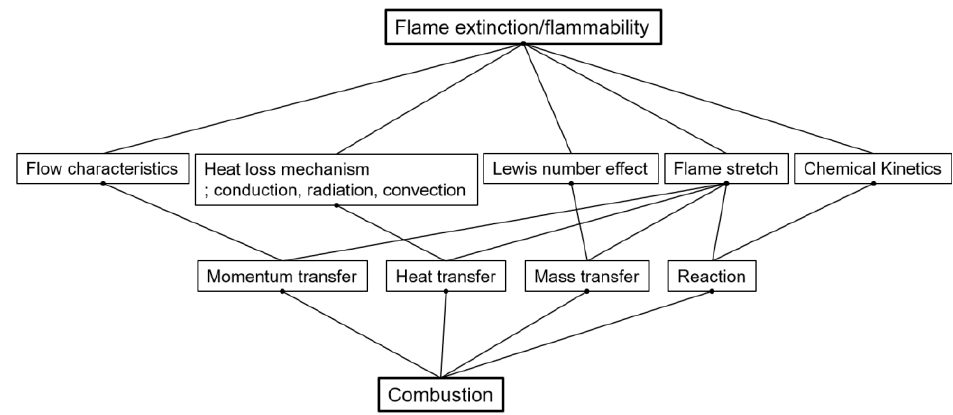
Figure 24. Synopsis of relations between the combustion phenomena and flammability limit. The lean limit flame characteristics according to fuel type should be thoroughly investigated to identify the dominant phenomena and develop a useful analytical model.